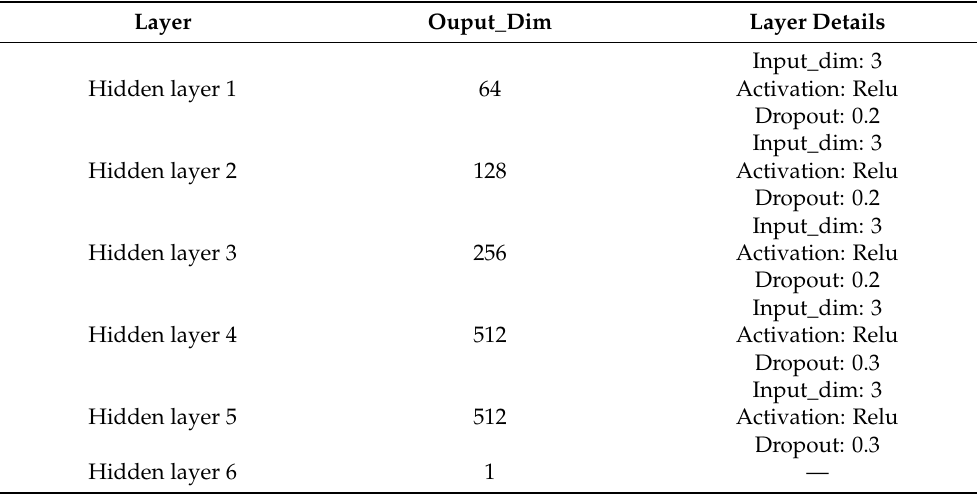
Figure 5. The structure of the proposed DNN. The detailed parameters of each layer in the regression network are shown in Table 1. Table 1. Details of the DNN.